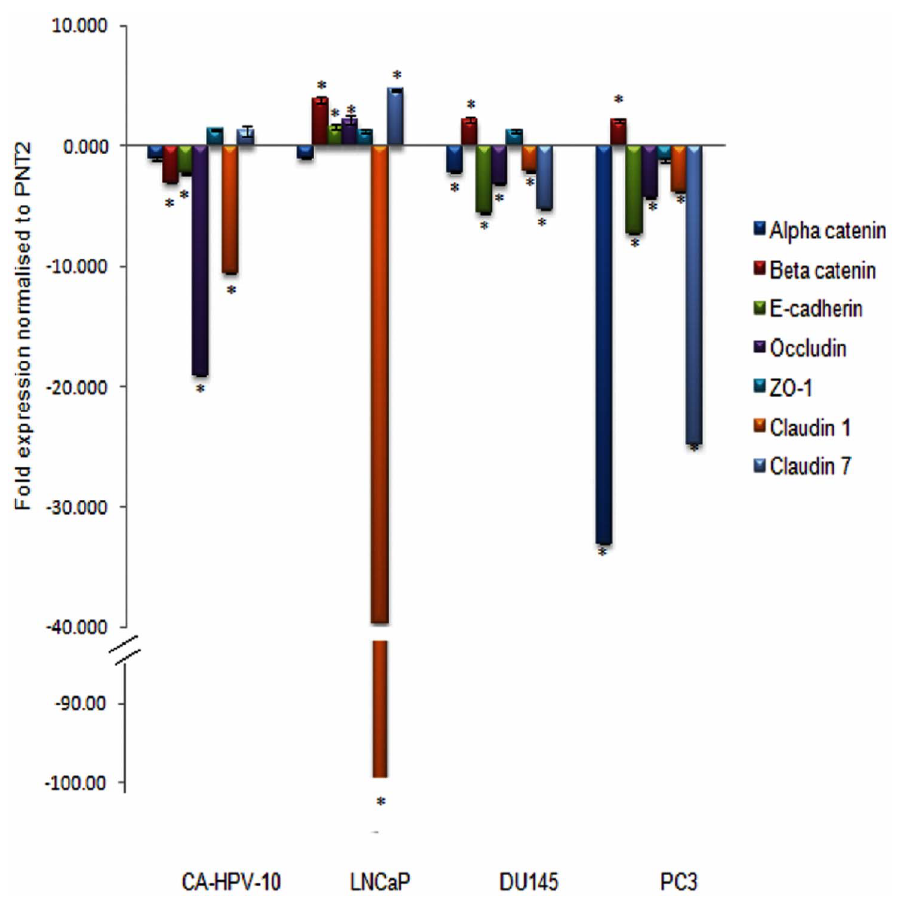
Figure 1. Differential mRNA expression of tight junction (Occludin, ZO-1, Claudin 1, Claudin 7) and adherence junctions ( a - catenin, b -catenin and E-cadherin) in prostate cancer cell lines from localised (CAHPV-10) and different metastatic sites (LNCaP metastatic to lymph nodes, DU145 metastatic to the brain and PC-3 metastatic to bone). Expression levels have been normalised to the normal prostate cell line PNT2 whose expression level has been set to 1. * denotes significant difference (P , 0.05) compared to PNT2.